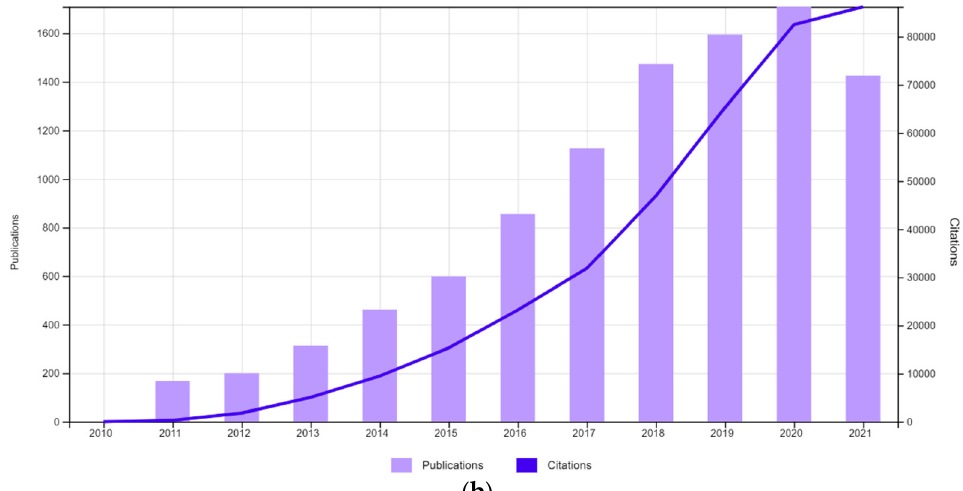
Figure 1. Updated number of publications and number of citations in the last ten years listed in the Web of Science platform using as search topics: ( a ) “Photodynamic Therapy AND Nanoparticles” and ( b ) “Photothermal Therapy AND Nanoparticles” (November 2021).